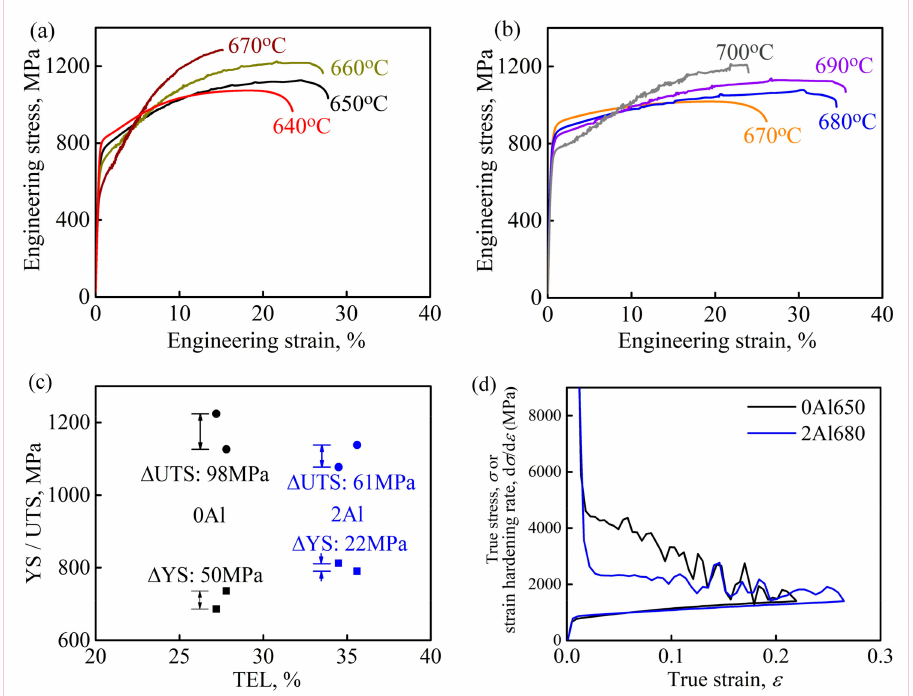
Figure 3. Engineering stress–strain curves of ( a ) 0Al steel and ( b ) 2Al steel annealed at di ff erent temperatures for 5 min. ( c ) The mechanical properties of 0Al steel annealed at 650 and 660 ◦ C and 2Al steel annealed at 680 and 690 ◦ C, respectively. ∆ YS and ∆ UTS are the di ff erence values of yield strength (YS) and ultimate tensile strength (UTS), respectively. ( d ) The strain hardening rate and true stress–strain curves of the 0Al650 and 2Al680